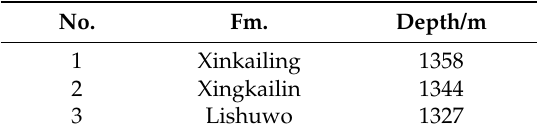
Table 3. The sample numbers, formations and burial depths of the samples from Well X for oxygen isotope experiments. See Figure 1 for the well